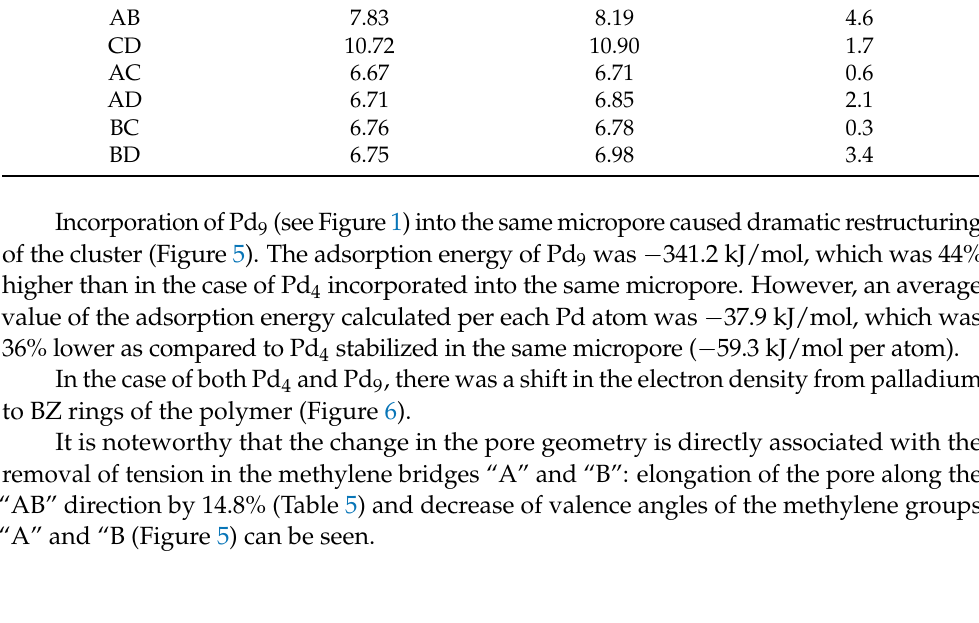
Figure 4. Optimized geometry of HPS micropore before ( a ) and after ( b ) incorporation of Pd 4 . To determine the changes in geometry of the polymer micropores during the incorpo- ration of Pd 4 cluster, the methylene groups, indicated in Figure 4 as “A”, “B”, “C” and “D”, were selected. Obviously, the most significant changes in the pore structure occurred in the area of the cluster adsorption (Table 4) since Pd 4 itself is much smaller than the pore and cannot fill completely the entire micropore. Incorporation of Pd 4 resulted in the increase in the pore diameter (“AB”) by 4.6%, which is associated with the adaptation of the pore geometry during the coordination of BZ rings with the cluster. At the same time, the va- lence angles of covalent bonds of the methylene groups “A” and “ B” decreased from 115 ◦ and 118 ◦ to 112 ◦ and 111 ◦ , respectively, which indicates the decrease in pore tension (the angles tend to 109 ◦ 28 (cid:48) , corresponding to sp 3 -hybridized carbon atoms). Significant changes in other distances (“BD” and “AD” by 3.4 and 2.1%) are associated with conformational changes that do not affect the valence angles of methylene groups. Table 4. Structure parameters of the polymer micropore in case of Pd 4 incorporation. Distance, Å